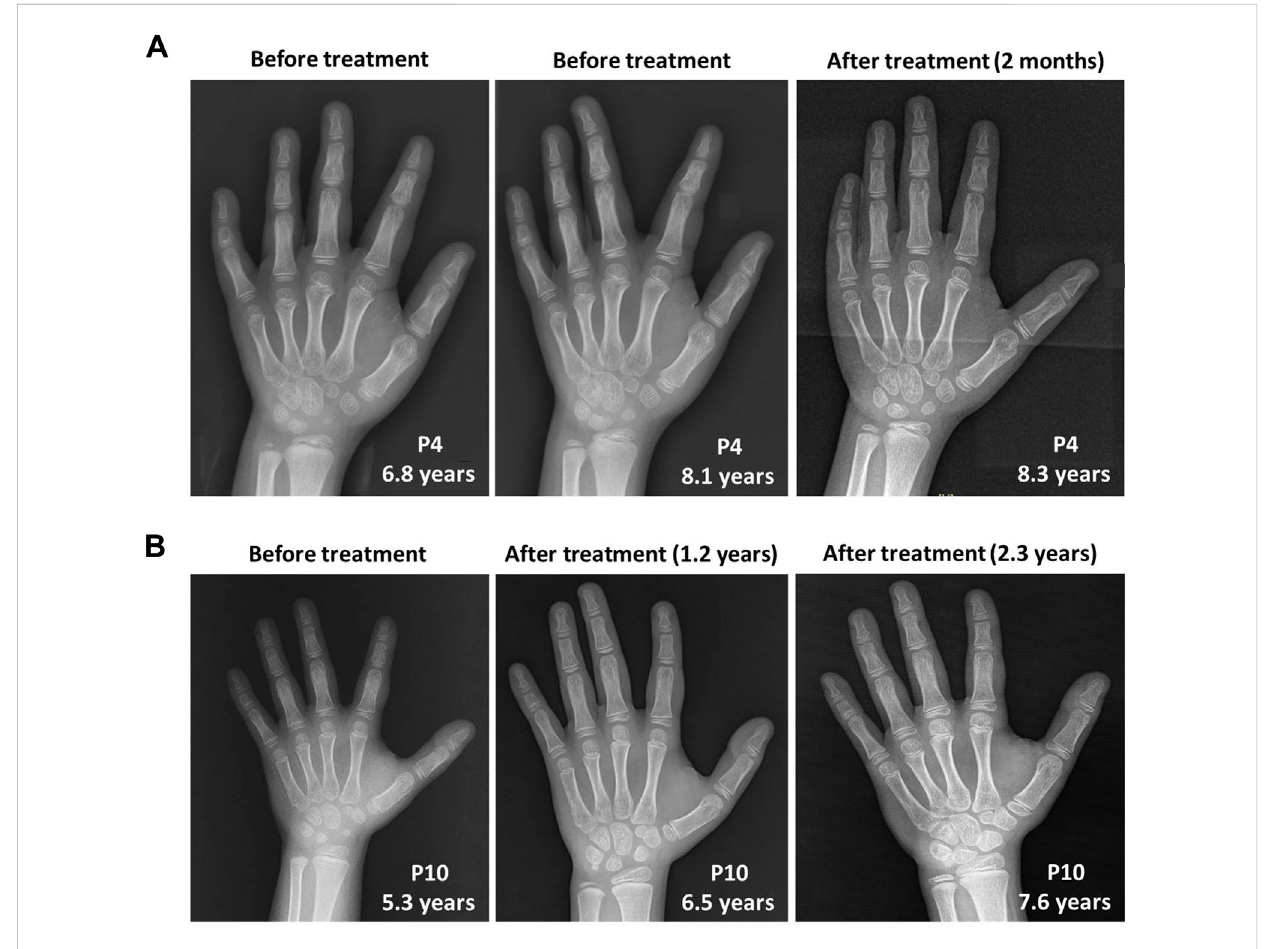
FIGURE 3 The skeletal X-ray images of two WSS patients before and after rhGH treatment. (A) P4. (B)